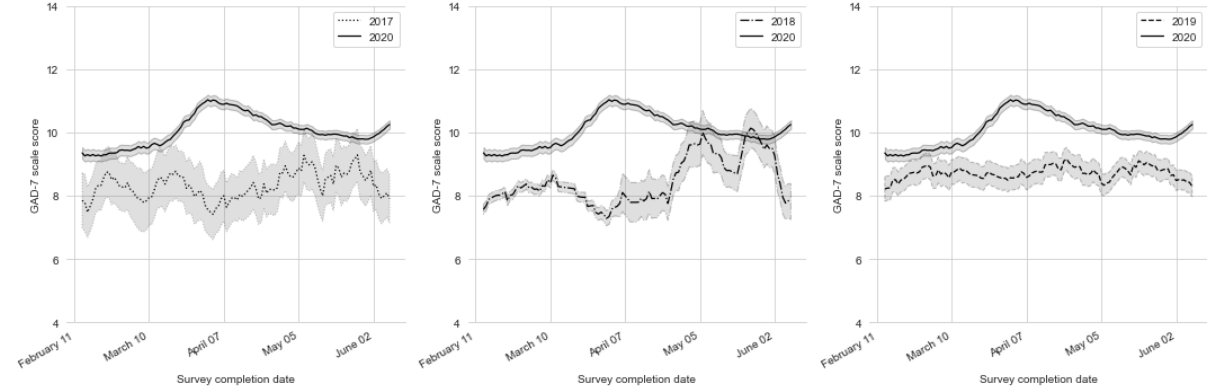
Figure 1. The 2-week GAD-7 score rolling averages from February 1, 2020 to June 9, 2020. The rolling averages from 2017, 2018, and 2019 are also presented. GAD-7: 7-item Generalized Anxiety Disorder